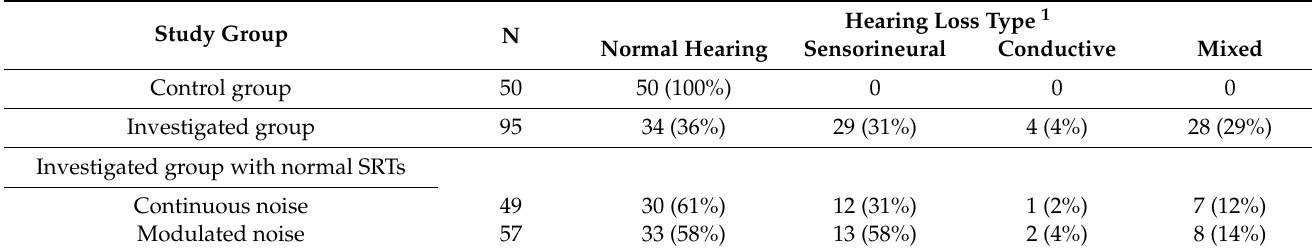
Table 2. Types of hearing loss in study